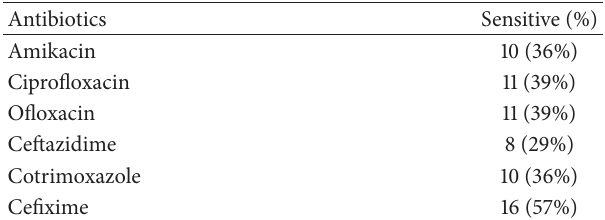
Table 5: Antibiotic susceptibility patterns of K. pneumoniae ( 𝑛 = 28